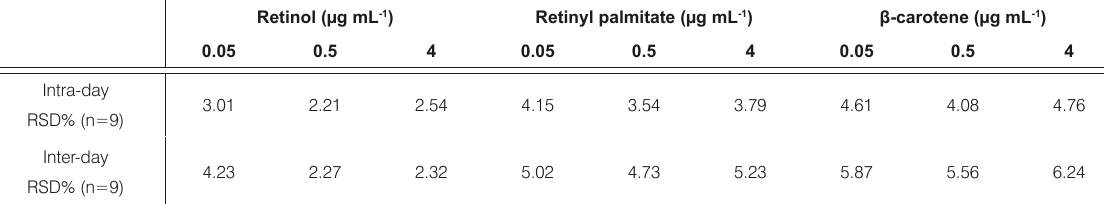
Table 3. Precision of analysis of Retinol, Retinyl palmitate and β -Carotene standards in mobile phase